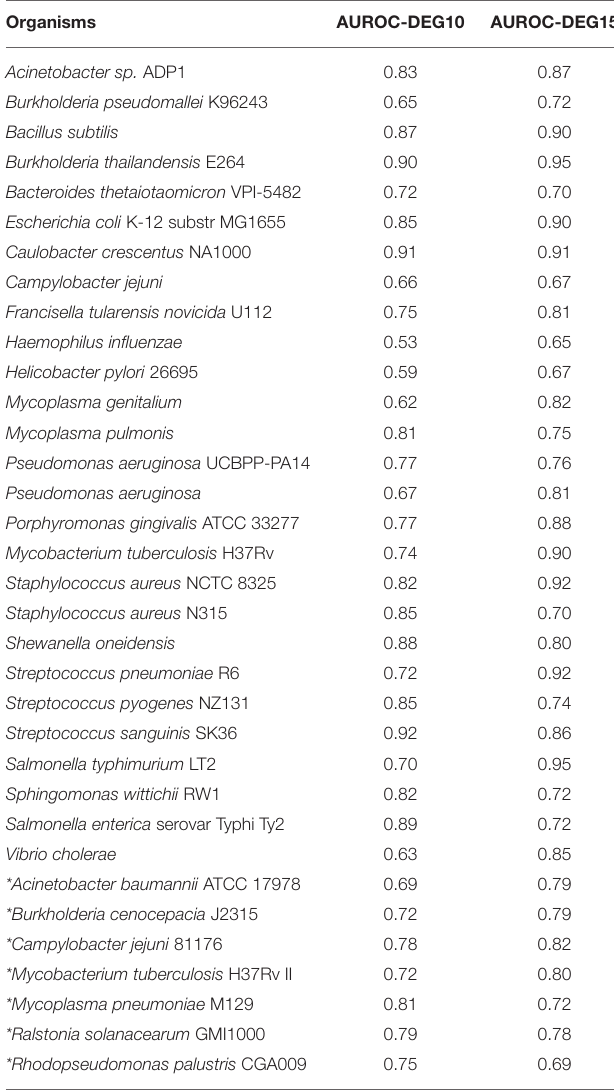
TABLE 1 | Table showing LOSO AUROC scores for DEG10 and DEG15 datasets.